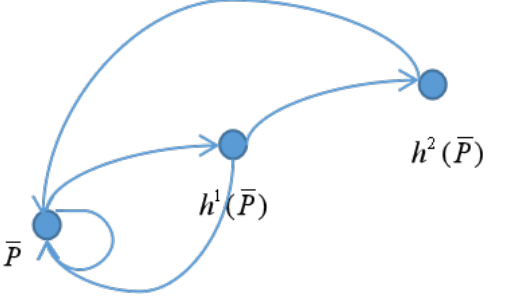
Figure 5. State transition process of estimation error covariance P ( k ) against DoS